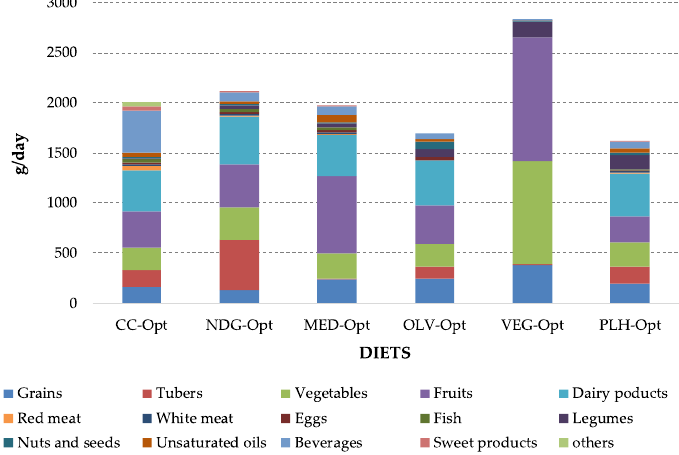
Figure 5. Distance (Dn) for optimal diets with different variation limits.